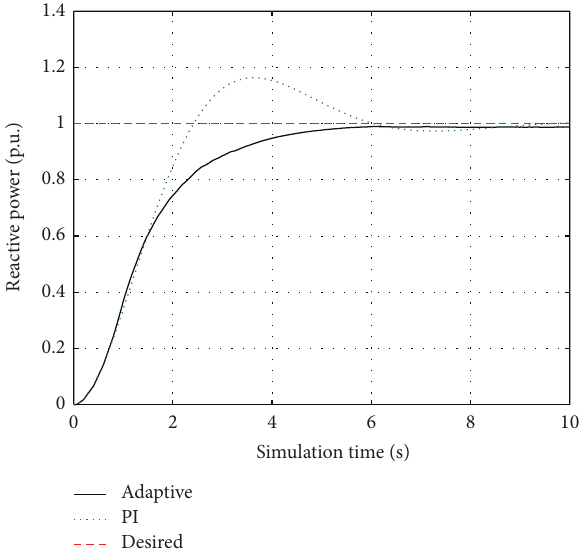
Figure 4: Reactive power regulation trajectories.